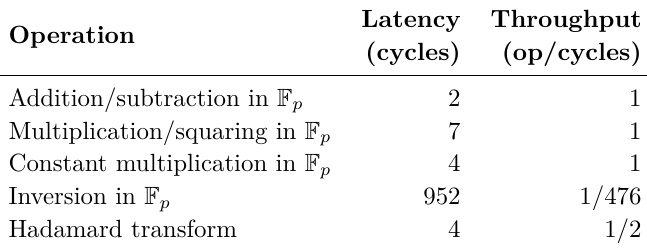
Table 3: Latency and throughput of field